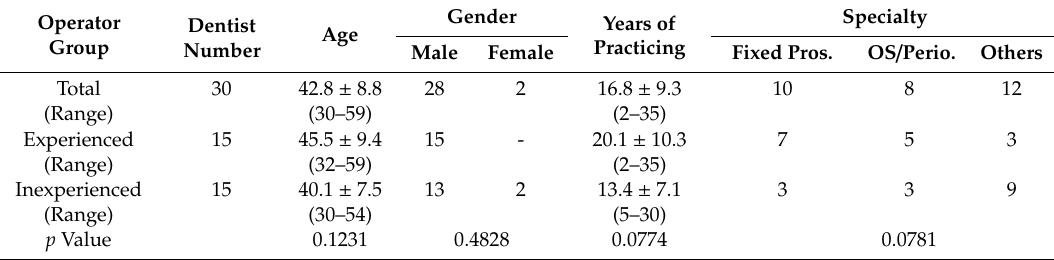
Table 1. Demographics and specialty of the